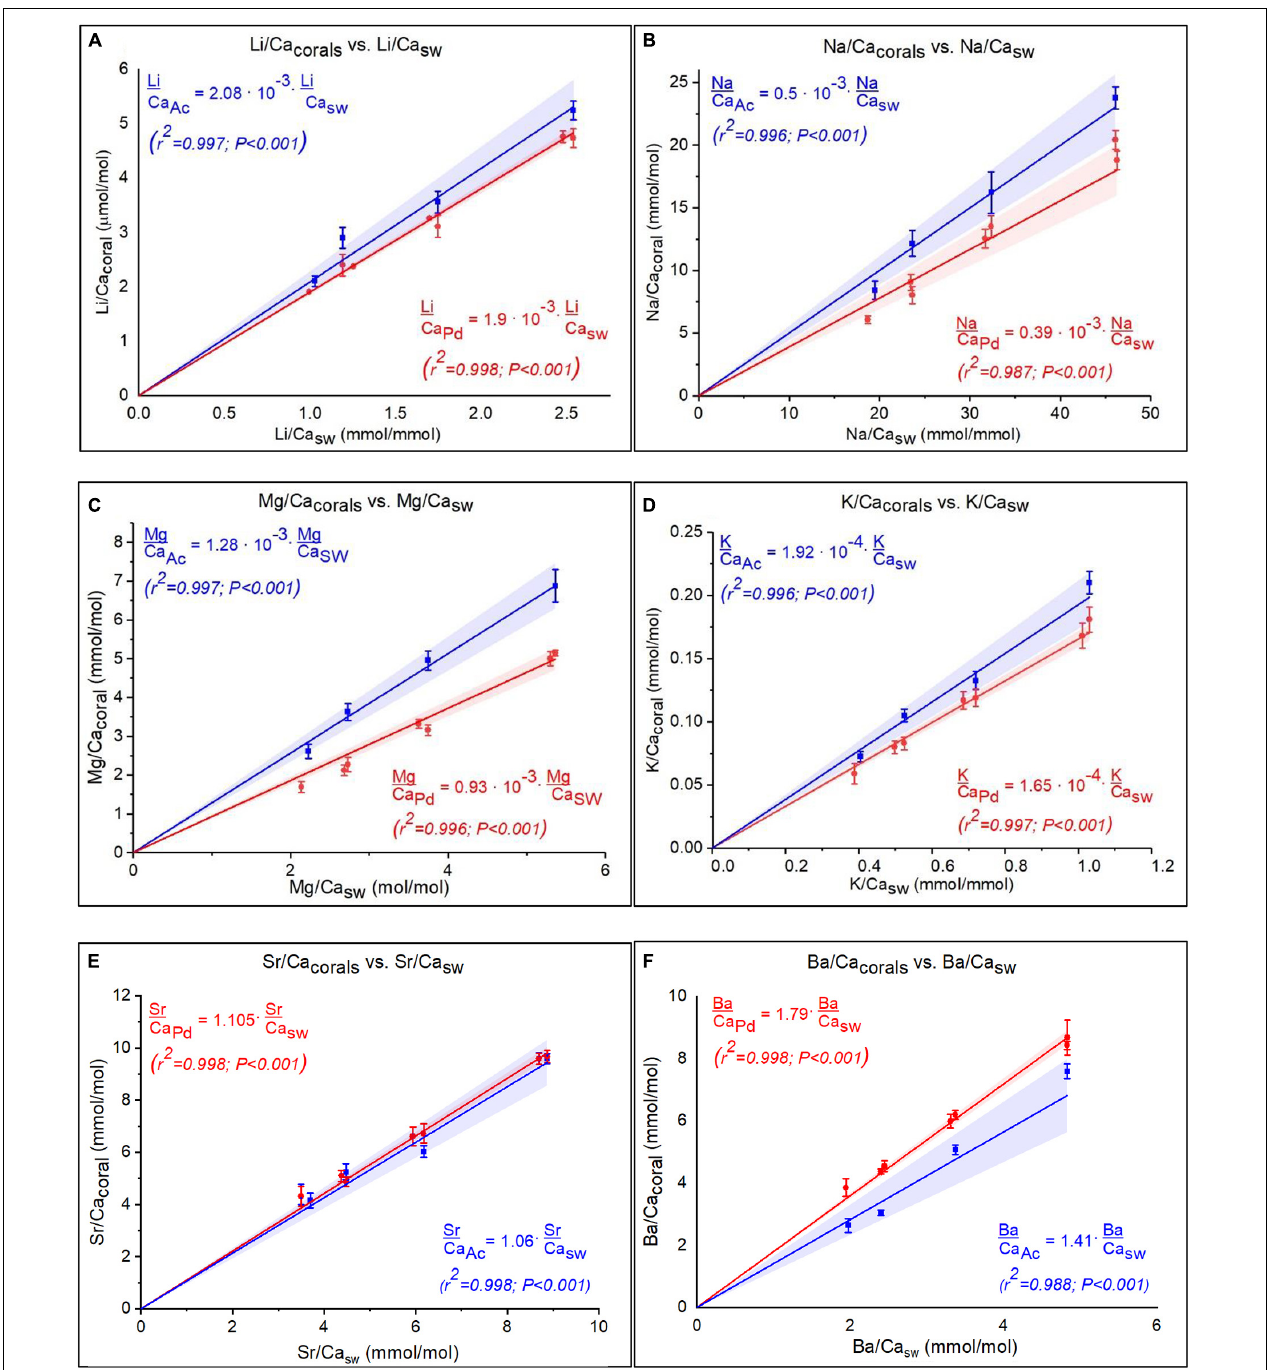
FIGURE 3 | (A–F) El/Ca coral as function of El/Ca SW under variable Ca SW for both species, for six elements ( Pocillopora damicornis in red and Acropora cervicornis in blue). The regressions show linear positive correlations for all elements. Note that for P. damicornis data for two separate experiment are shown with slight differences that are within the error on the replicates. The linear regressions that cross the origin imply constant distribtion coefficient for all elements. The shaded area is the 95% confident bands.